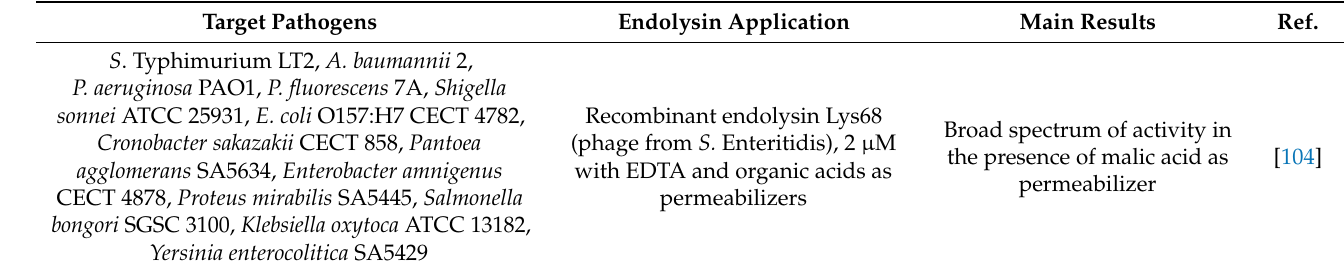
Table 7. Endolysin applications against Salmonella